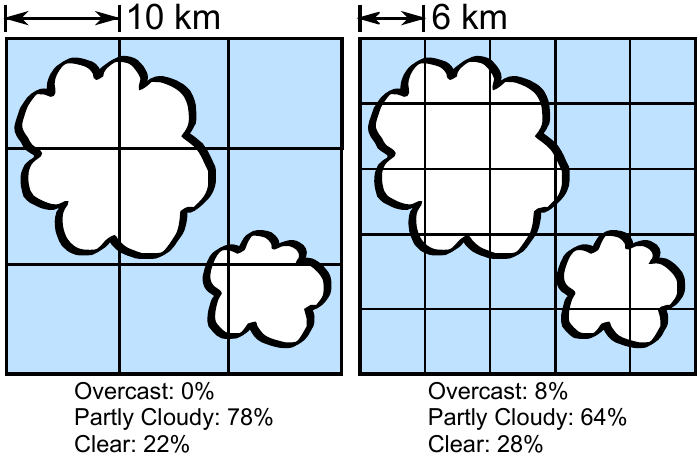
Figure 18. Hypothetical scene illustrating the effects of level 2 resolution on sampling. At 10 km resolution (left), all nine retrieval boxes are clear or partly cloudy, and can be used for DT retrieval. At 6 km resolution (right), a greater proportion of the scene is fully clear, but two retrieval boxes of the 25 are fully overcast and excluded from DT retrieval.